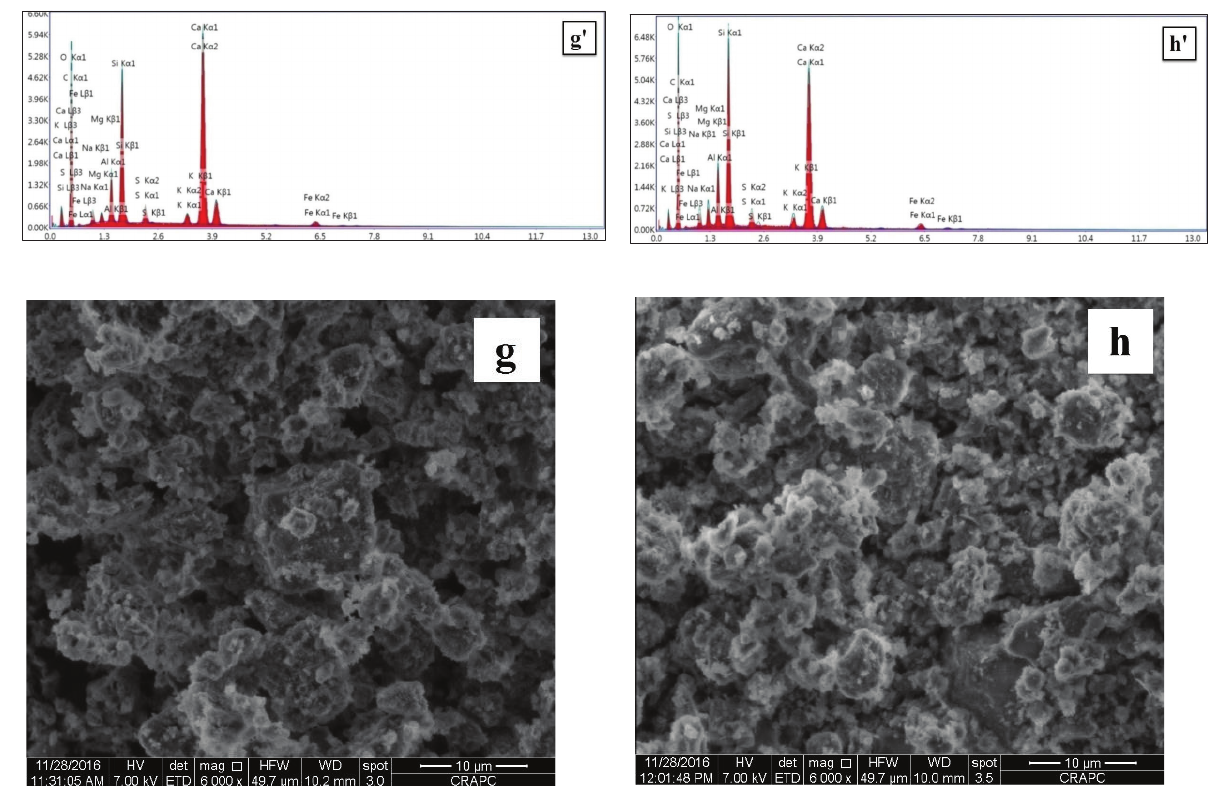
Figure 10: SEM and EDS analyses of soil treated with (4% bentonite+8% cement) and (2% bentonite+10%